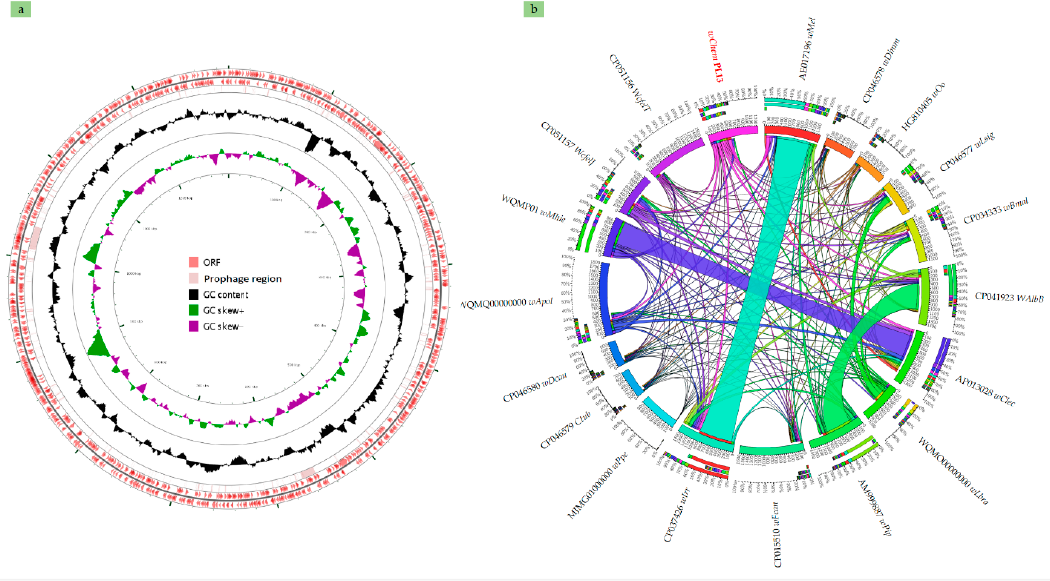
Figure 2. The complete chromosome of the Wolbachia sp. wChem PL13. ( a ): circular map showing the annotation of the whole genome. ( b ): rhizome showing gene sharing between Wolbachia genomes.